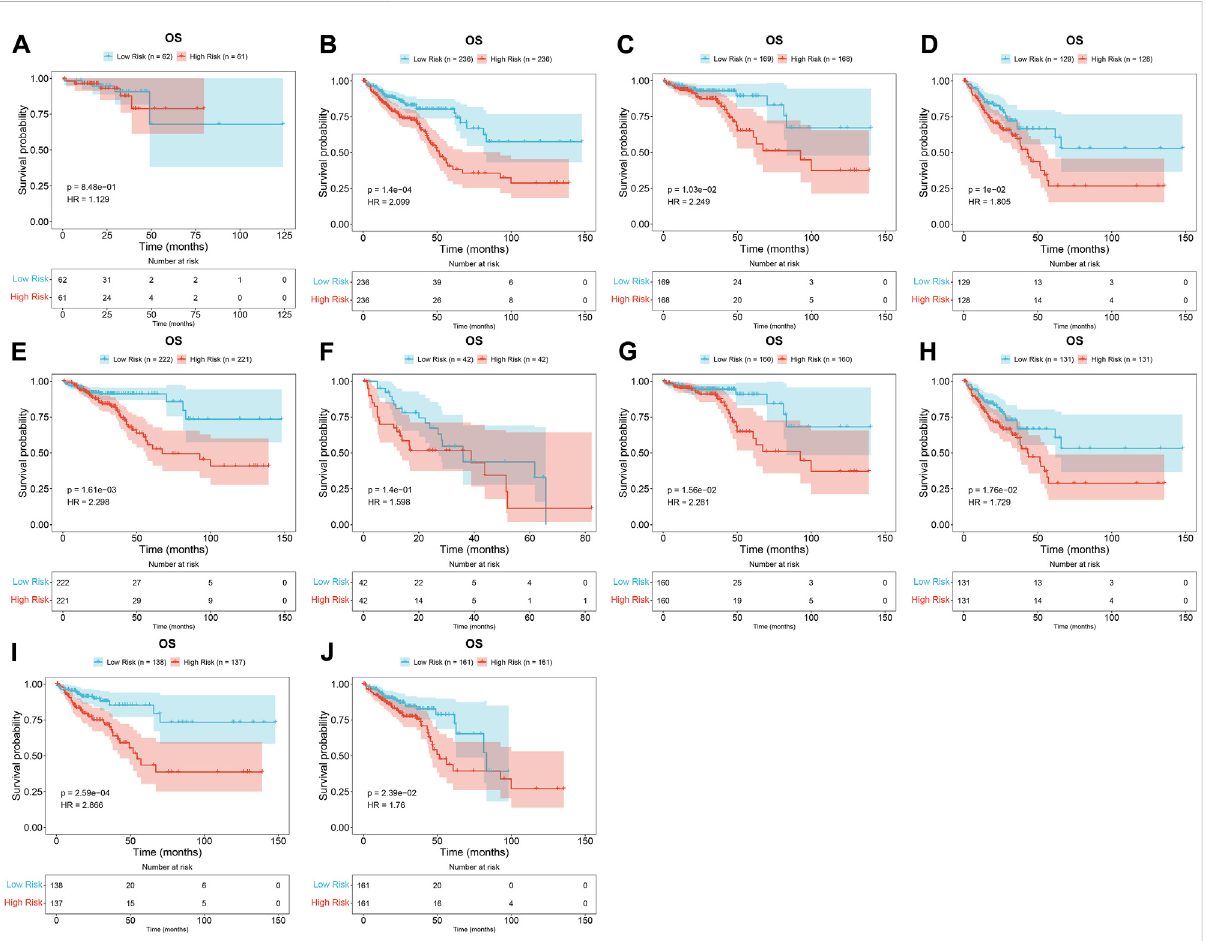
FIGURE 4 Oxidative stress-related gene signature is independent of other clinical features in predicting CRC patients ’ prognosis. (A – J) Subgroup analysis for the OS difference between high- and low-risk subsets in each subgroup strati fi ed by (A,B) T (T1 – 2 and T3 – 4), (C,D) N (N0 and N1 – 2), (E,F) M (M0 and M1), (G,H) pathological stage (stage I – II, stage III – IV), or (I,J) sex (female and male) in the TCGA dataset. N =